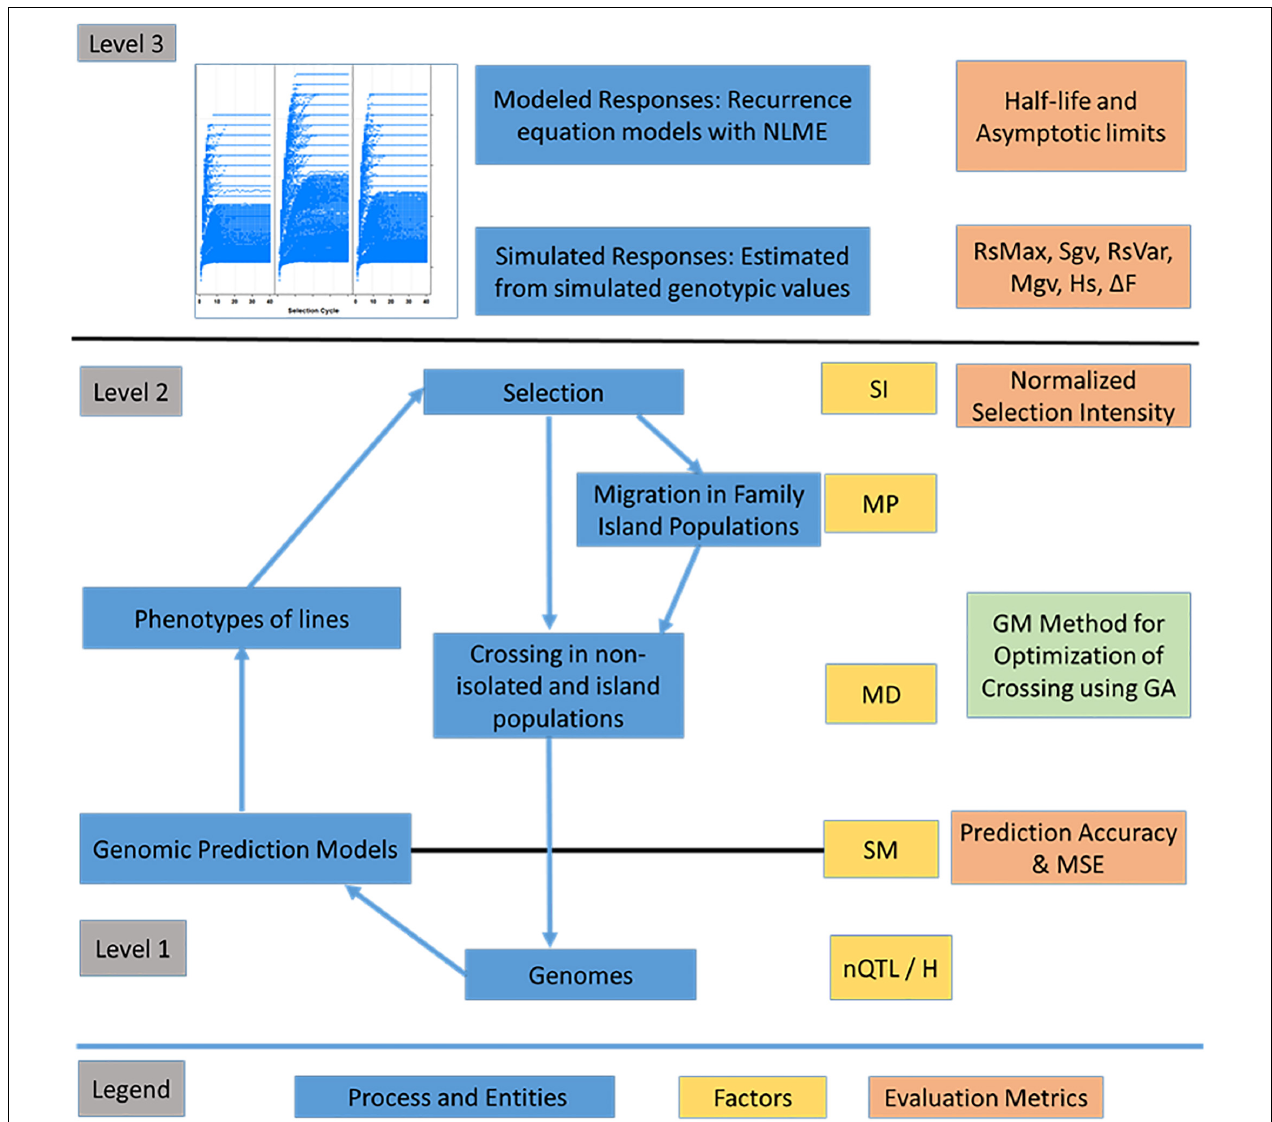
FIGURE 4 | Overview of the recurrent selection process. Representation of entities such as genomes, associated F 5 -derived lines and processes such as the estimation of marker effects, selection, migration and crossing. Levels correspond to layers of information with level 1 comprising genomic information, level 2 comprising phenotypes of lines within and across family islands, and level 3 comprising higher-level information including responses across cycles of selection. The factors include nQTL and H at the genome level, selection method (SM) including phenotypic selection (PS), genomic selection (GS), and weighted genomic selection (WGS). The factors at level 2 include selection intensity (SI - top 10% selected fraction); Mating Design (MD), which includes Hub Network, Chain Rule, Random Mating, and Genomic Mating; Migration Policy (MP), which includes: “Isolated Selection,” “Best Island,” “Random Best,” and “Fully Connected” policies. Among the MD levels, GM method involves application of evolutionary multi-objective optimization to minimize inbreeding and maximize gain and usefulness. Level 3 is characterized using evaluation metrics such as half-life and asymptotic limits derived from recurrence equation models and metrics such as Standardized Responses (Rs), Standardized genotypic variance (Sgv), Maximal genotypic values (Mgv), and efficiency of converting loss in genetic variance into gain (RsVar) derived from simulated outcomes. Other metrics include prediction accuracy and MSE for GP models (RR-REML) and expected heterozygosity